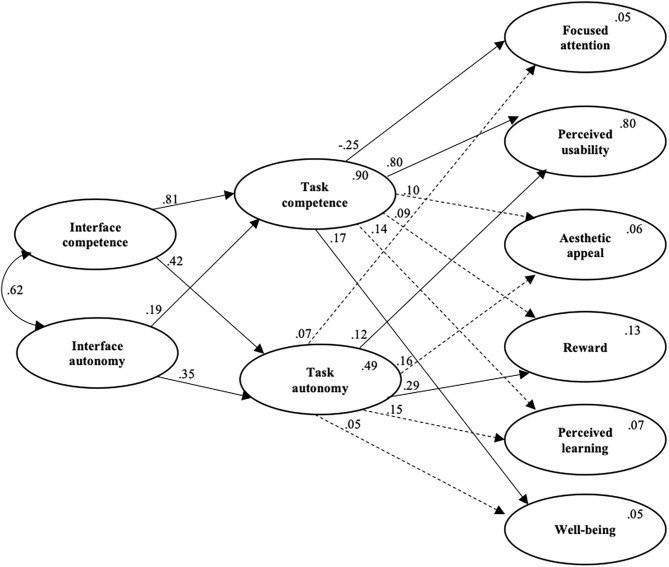
Final structural equation model. Results from the structural equation model (SEM). Values within the endogenous variables are the R2 values. Solid lines are significant coefficients (p < 0.05), whereas stippled lines are non-significant coefficients (p > 0.05). All values are standardized regression coefficients. For simplicity, we have removed the measurement model.